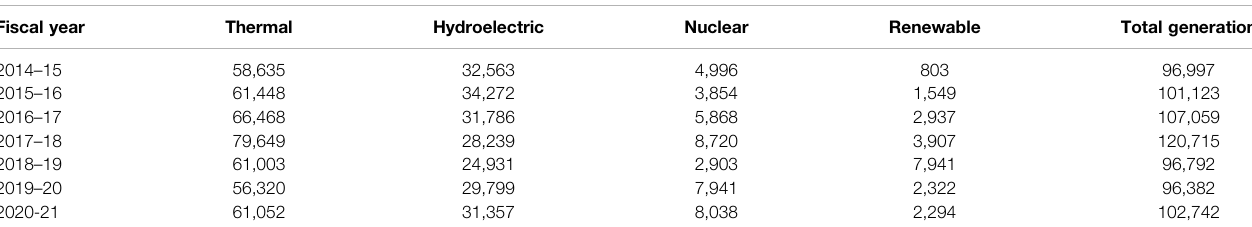
TABLE 2 | Power installed capacity sources.